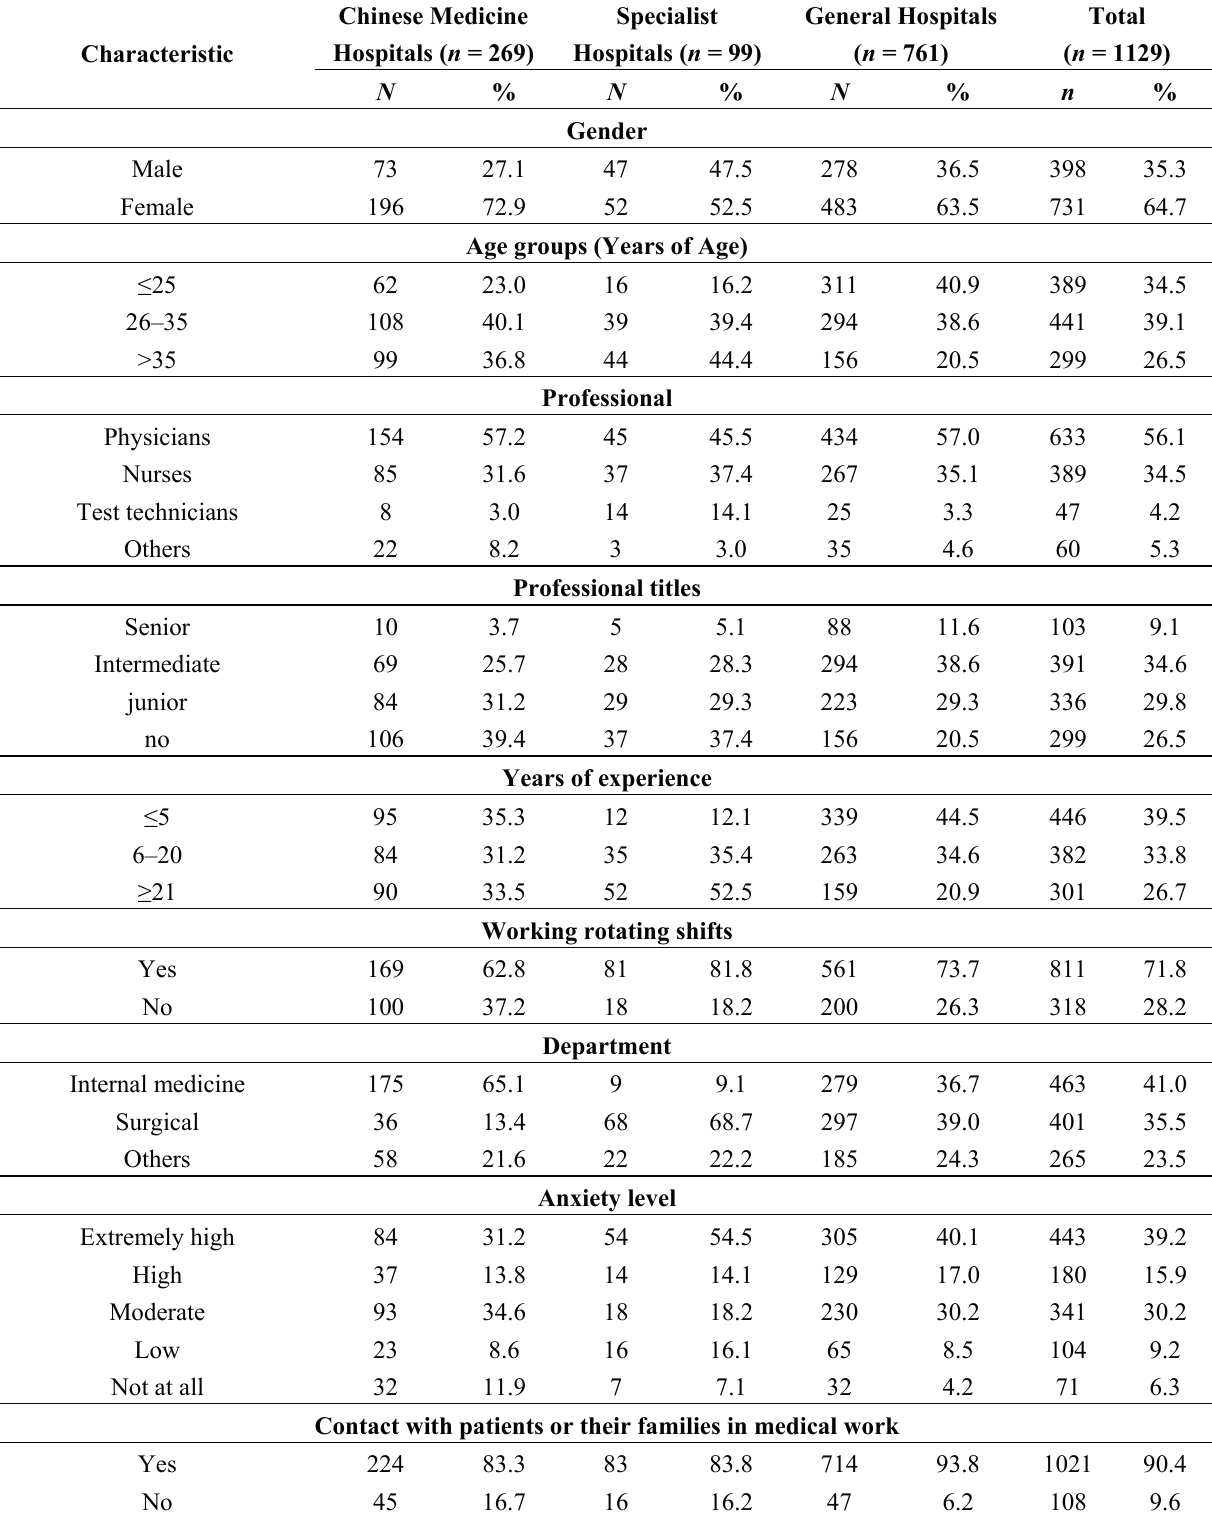
Table 1. Demographic characteristics of